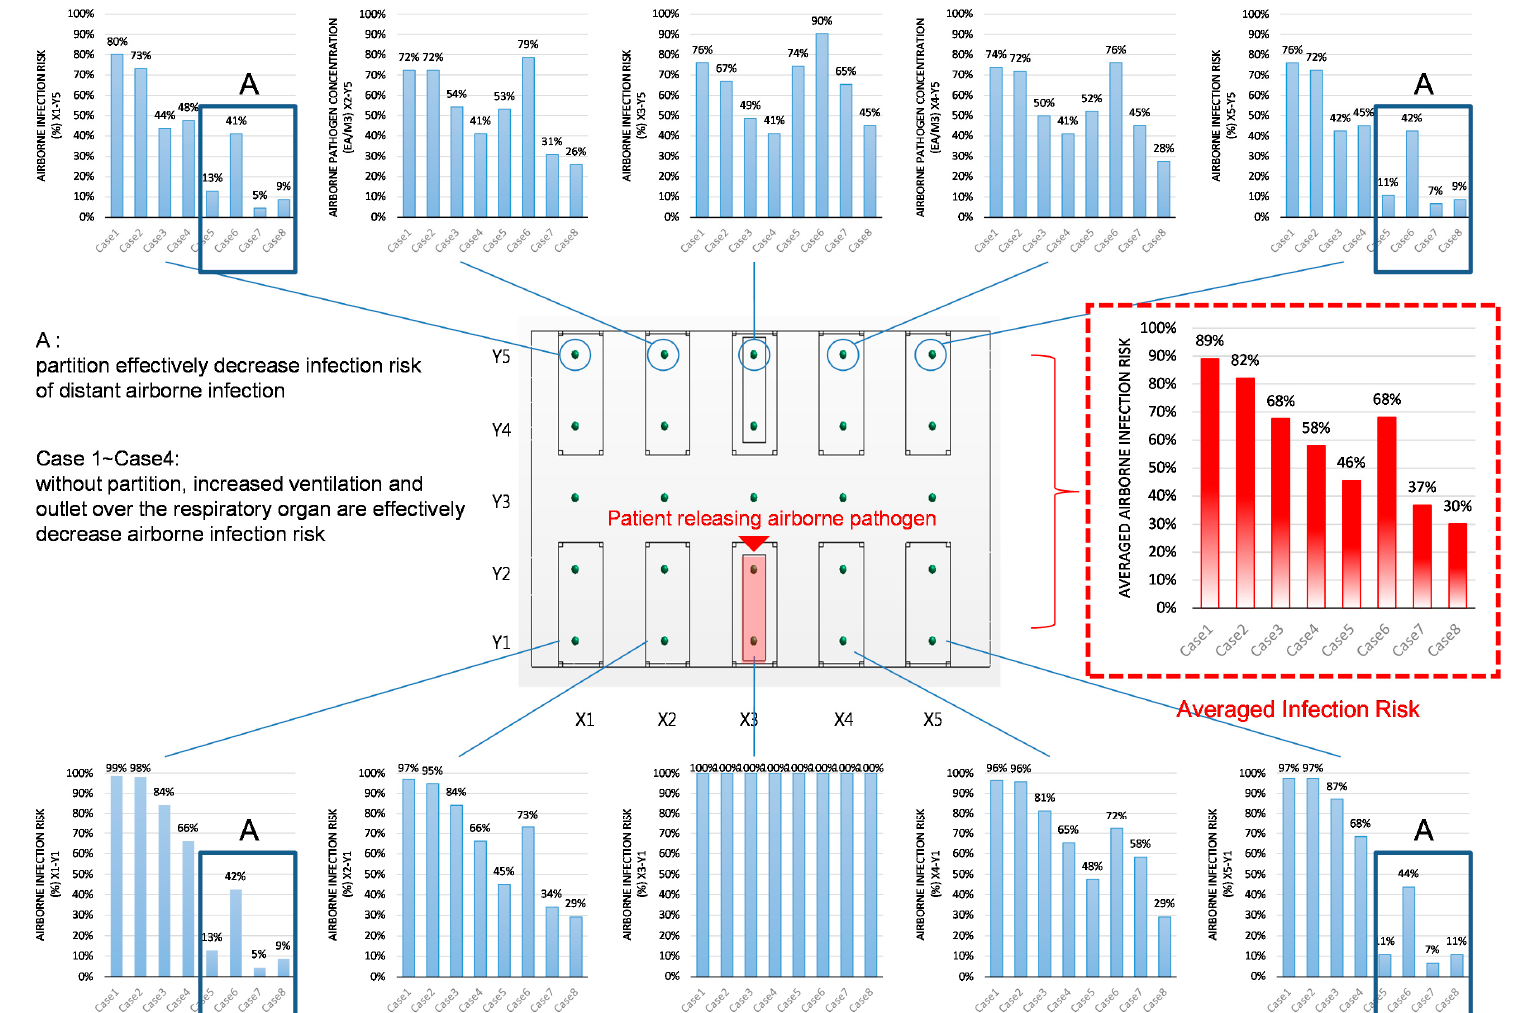
Figure 7. Airborne infection risk for all cases (4 h of exposure).